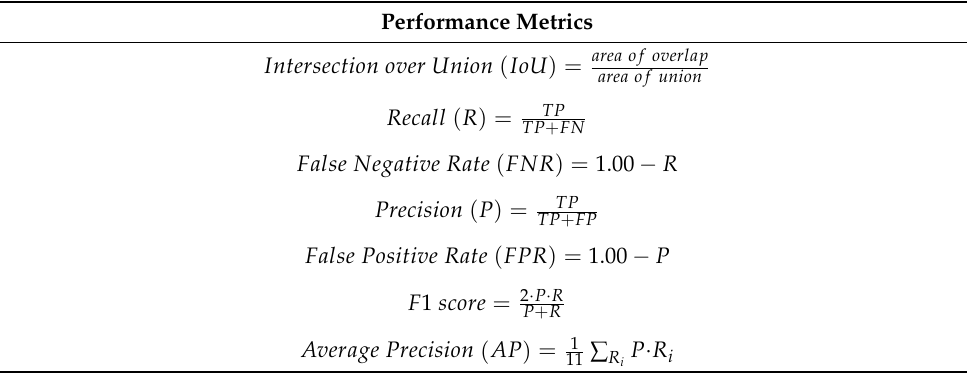
Table 2. Performance metrics that were used to evaluate the YOLOv4 models are described below. This evaluation is based on the Pascal VOC Challenge